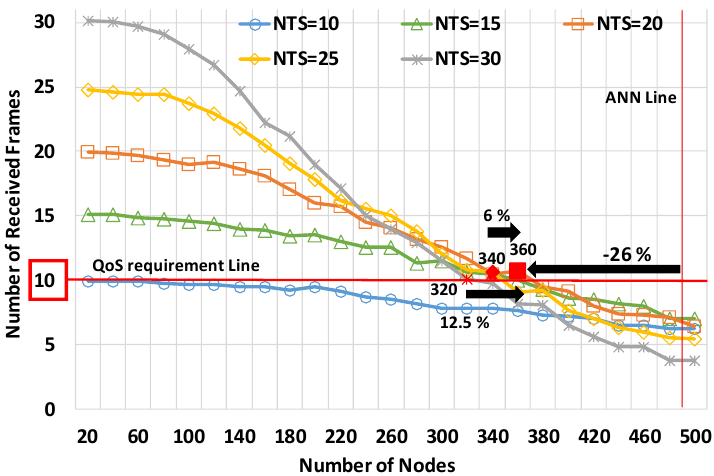
Figure 9. The number of received frames for the number of nodes in the uniform node distribution model at a relative speed of 120 km/h.